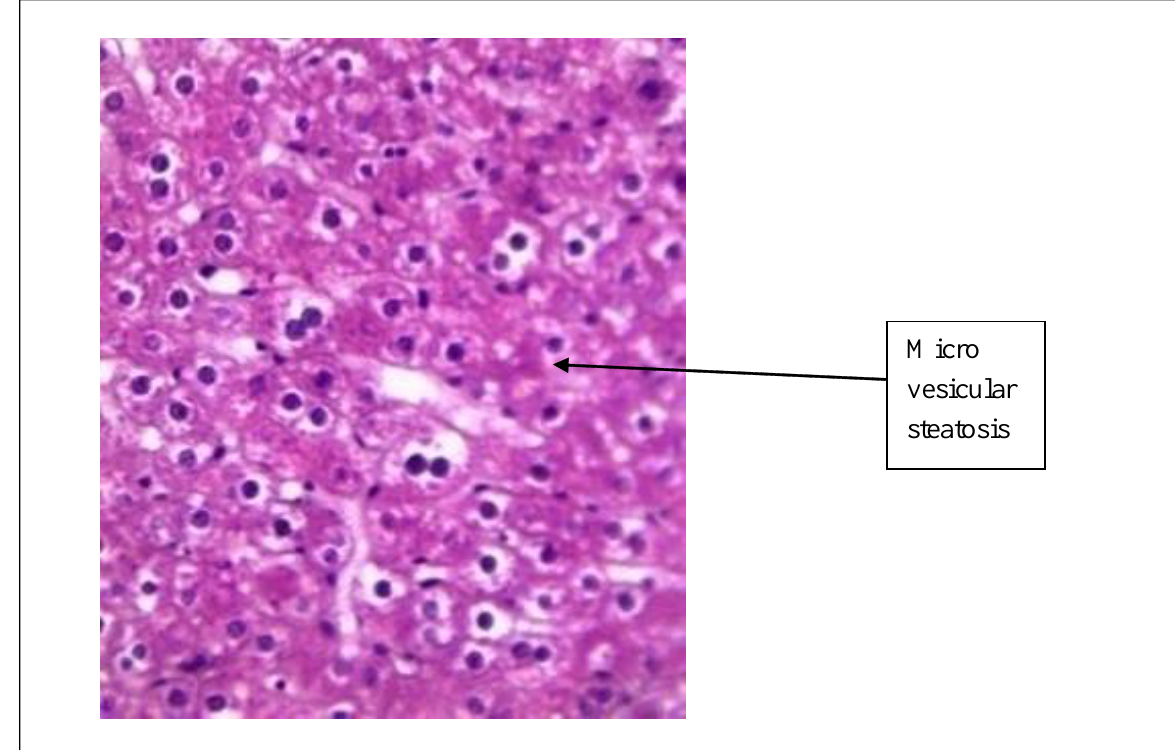
Figure 3: Liver section from HFD group; micro vesicular steatosis (MV). X500  m